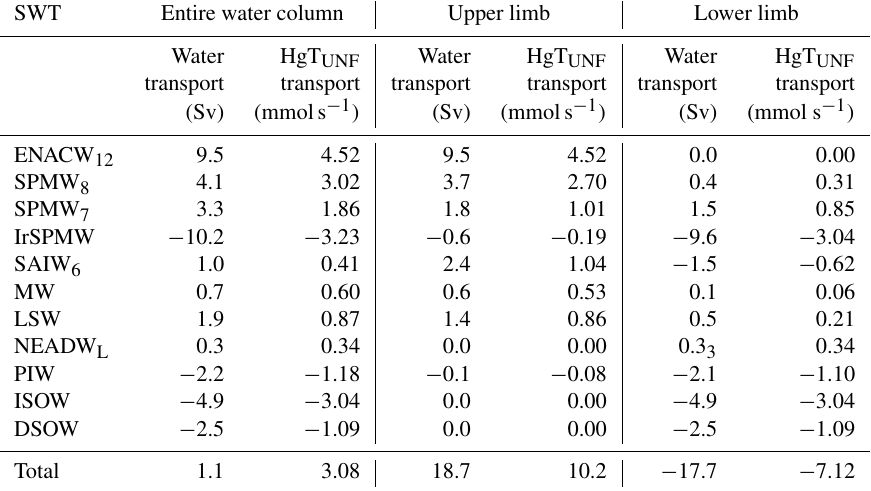
Table 2. Water and total Hg in unfiltered samples (HgT UNF ) transported by the upper and lower limbs of the Atlantic Meridional Overturning Circulation. Positive (negative) transport corresponds to northward (southward) flow. SWT Entire water column Upper limb Lower limb Water HgT UNF Water HgT UNF Water HgT UNF transport transport transport transport transport transport (Sv) (mmols − 1 ) (Sv) (mmols − 1 )